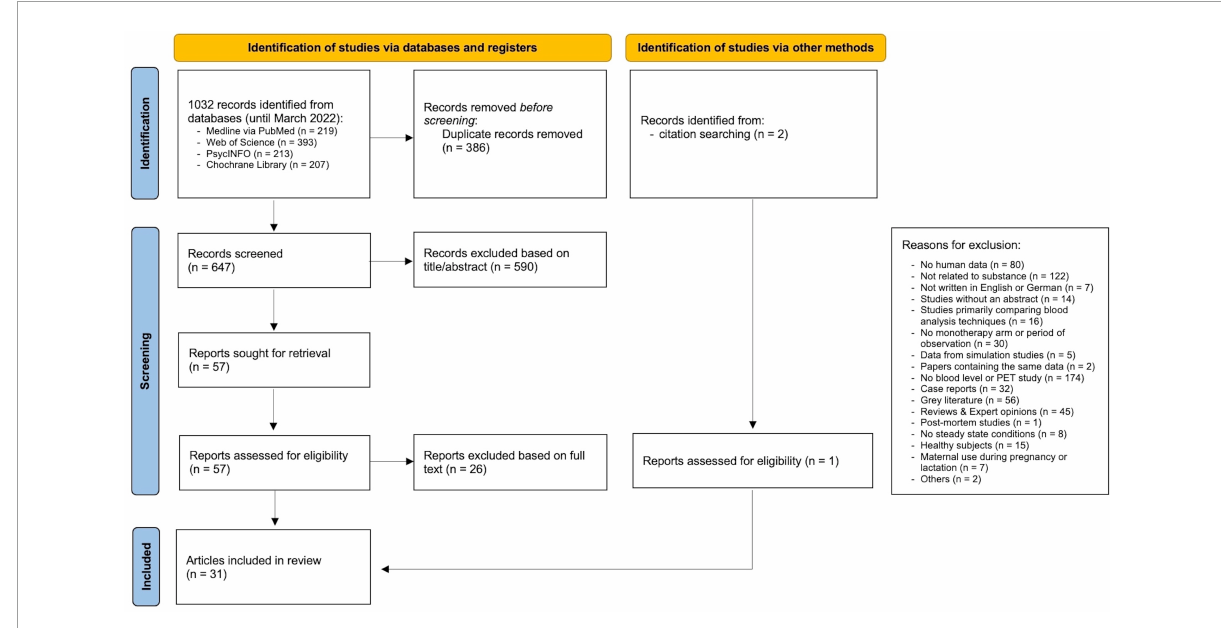
FIGURE1 PRISMA flowchart of study selection. From Page et al.